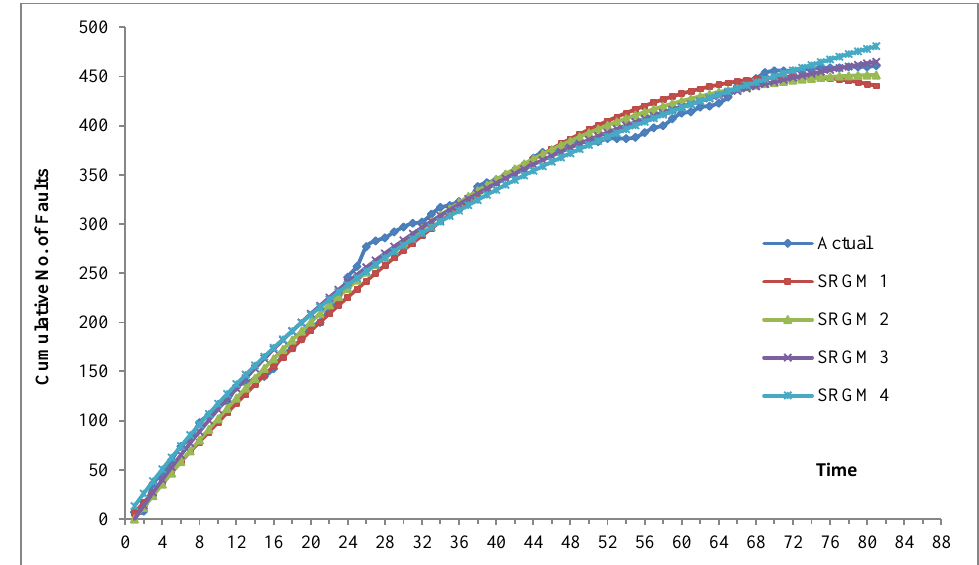
Fig. 2. Goodness of fit curve for data set